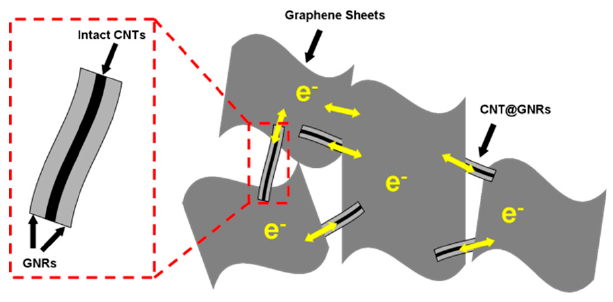
Figure 6. The interconnected structure of CNT@GNR@GA to enhance electron transfer.